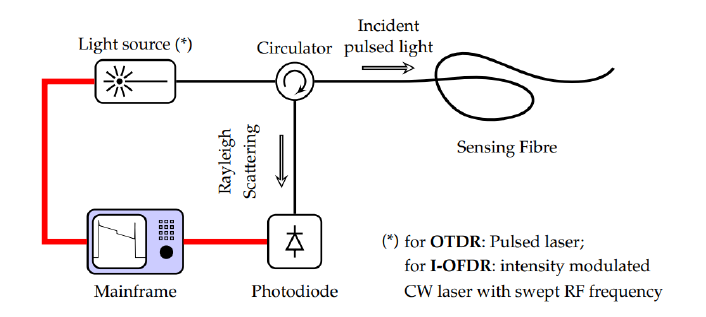
Figure 29. The principle of operation of the OTDR and I-OFDR schemes (CW—continuous wave; OTDR—optical time domain reflectometer; I-OFDR—incoherent optical frequency domain reflec- tometer; RF—radio frequency). Reprinted under Creative Commons CC BY license [114].